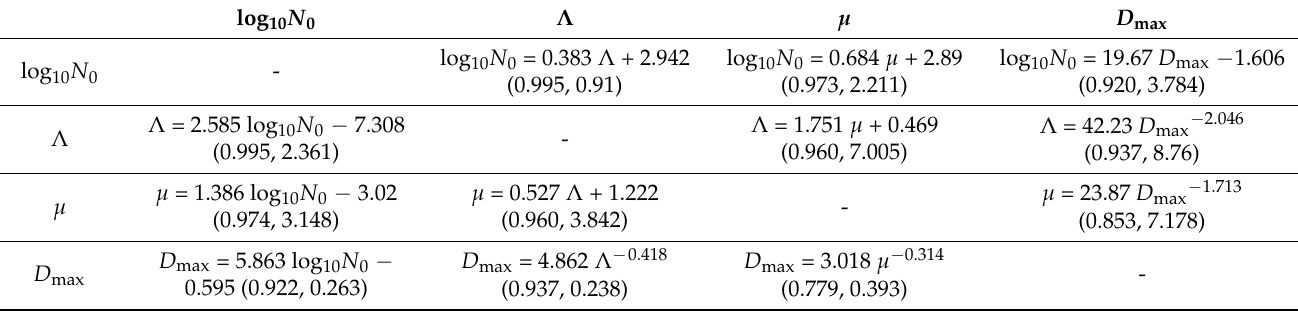
Table 5. Summary of relationships among gamma PSD parameters. The numbers in the brackets are the correlation coefficient and the root-mean-square error,